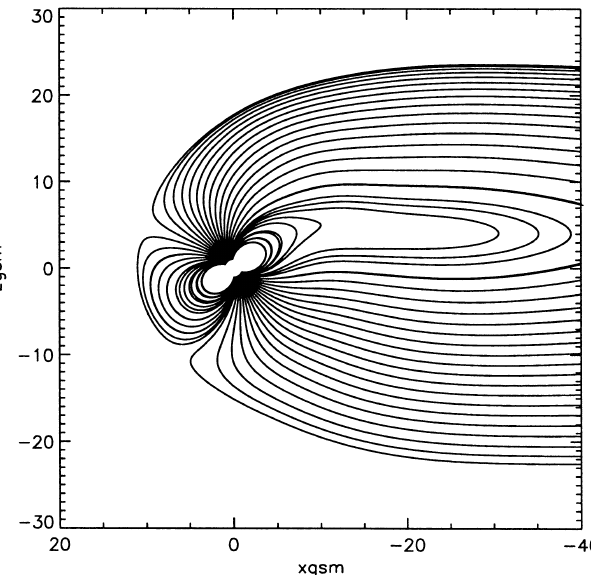
Fig. 6. Field lines are plotted for colatitudes lower than 28 (cid:14) or higher than 162 (cid:14) with a 2 (cid:14) step for Kp = 1 and tilt = 35 (cid:14) . The diameter of the tail for xgsm (cid:136) (cid:255) 40 Re is approximately 46 Re. The subsolar point distance is around 12 Re